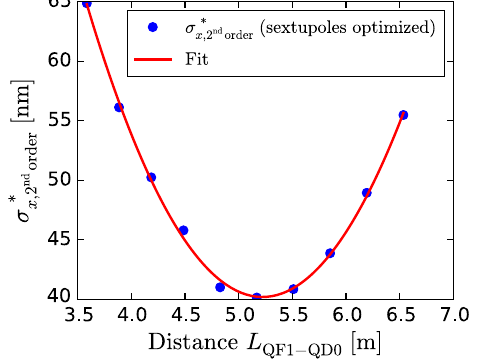
FIG. 18. Example of L scan for σ (cid:1) x; 2 minimization QF 1 -QD 0 ndorder ¼ 658 . 9 m lattice. The original distance applied on the L FFS L after FFS length reduction was 5.8 m. QF 1 -QD 0